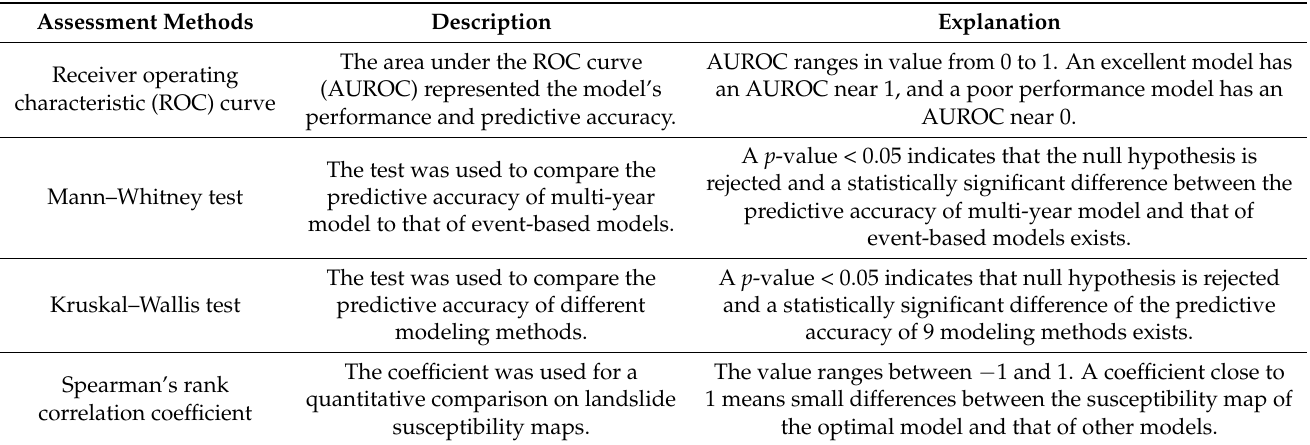
Table 3. Description and explanation of the model performance assessment